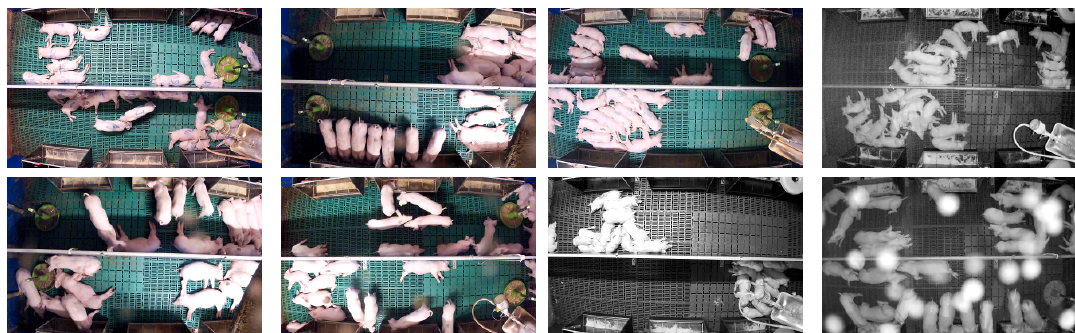
Figure 7. Some sample images from the data set used: Note the poor lighting conditions, the dense grouping of the animals, and the distortions during active night vision caused by dirt on the